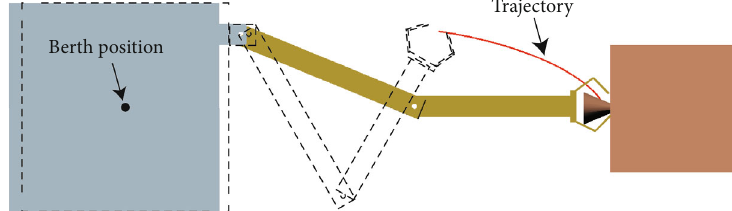
Figure 8: Optimized berth position and motion process for the planning case of zero attitude disturbance.